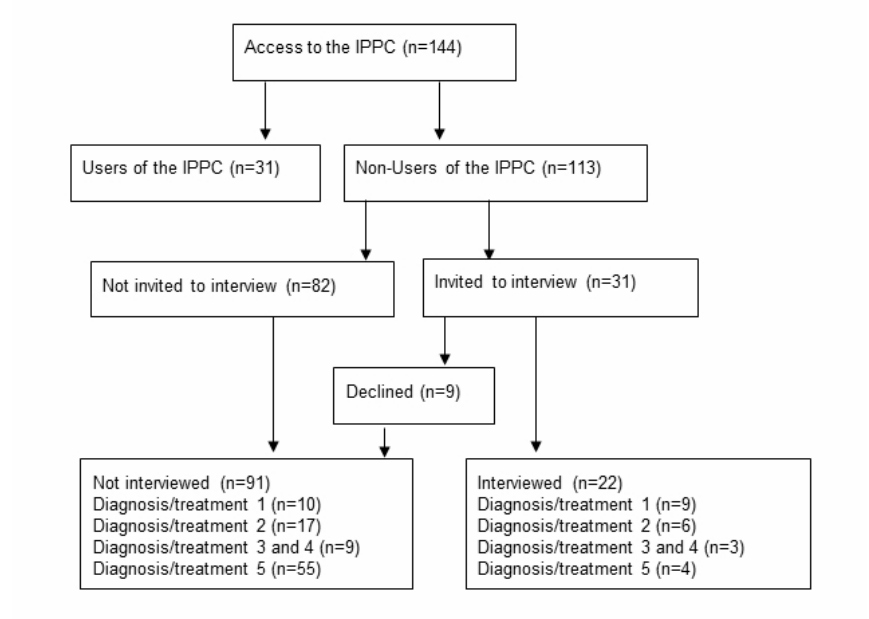
Figure 2. Patient recruitment for the interviews. Diagnosis/treatment 1: Liver transplantation. Diagnosis/treatment 2: Testicular cancer. Diagnosis/treatment 3: Autologous stem cell transplantation. Diagnosis/treatment 4: Advanced cancer and participation in clinical drug trials. Diagnosis/treatment 5: Type 1